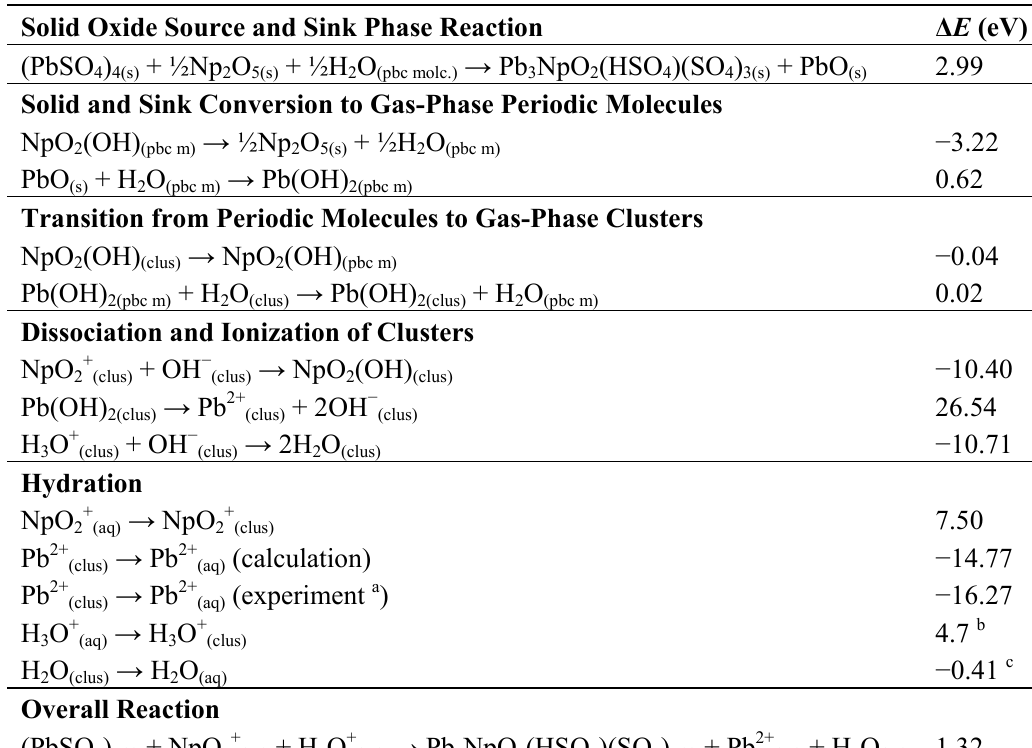
Table A1. Neptunyl (NpO 2+ ) Incorporation into Anglesite (PbSO